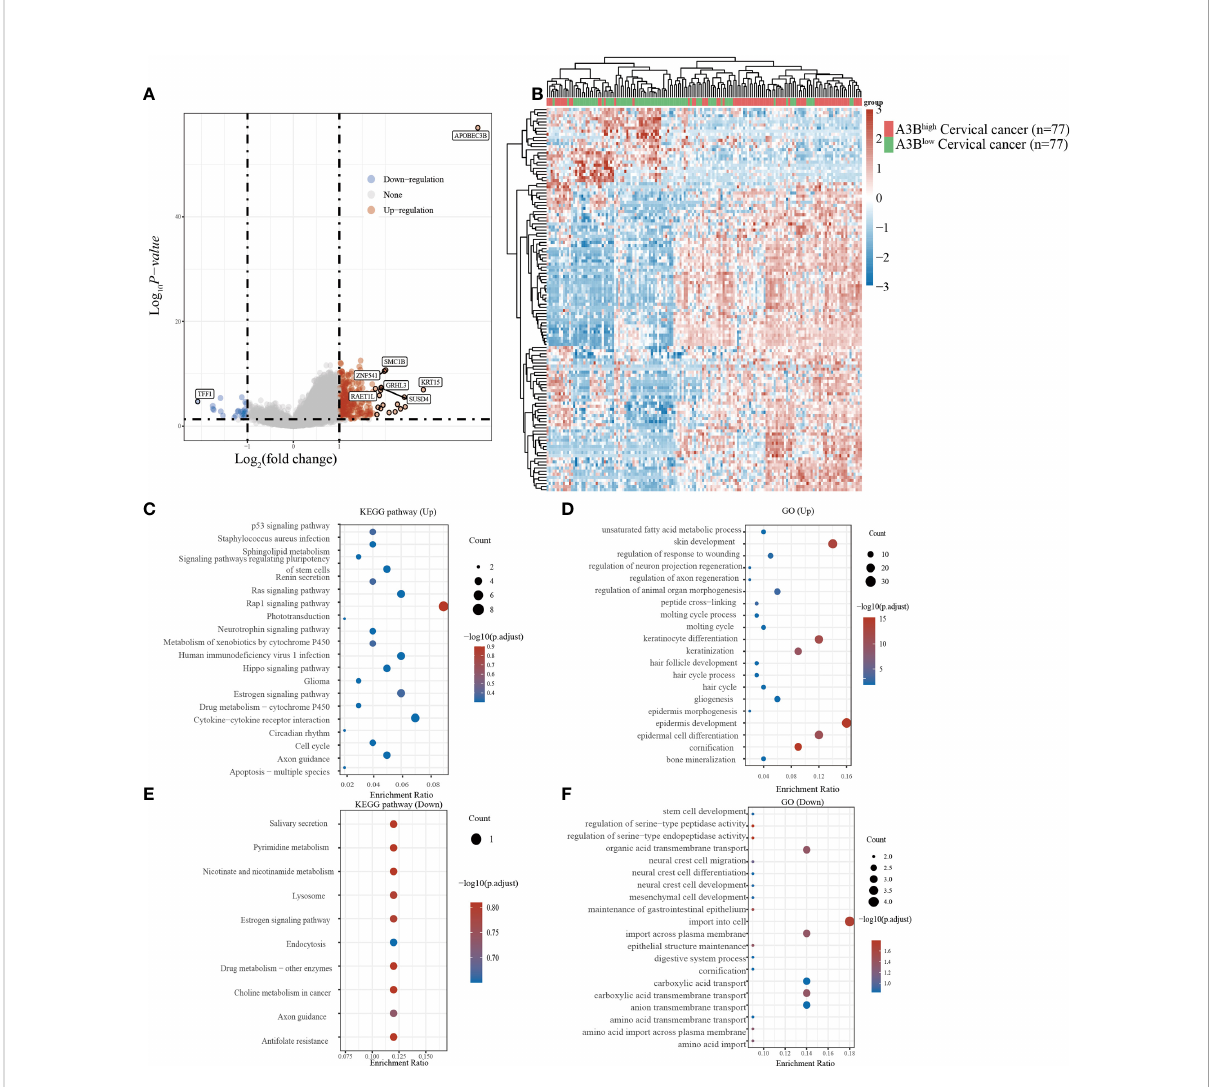
FIGURE 2 Different gene expression patterns and enrichment analyses of APOBEC3B high and APOBEC3B low in expression cervical cancer in TCGA. (A) A volcano plot for differential gene expression in TCGA samples with high and low A3B expression. In total, 124 upregulated genes and 27 downregulated genes were identi fi ed. (B) The heatmap analysis of differential genes. (C) KEGG pathway analysis of upregulated genes. (D) GO analysis of upregulated genes. (E) KEGG pathway analysis of downregulated genes. (F) GO analysis of downregulated